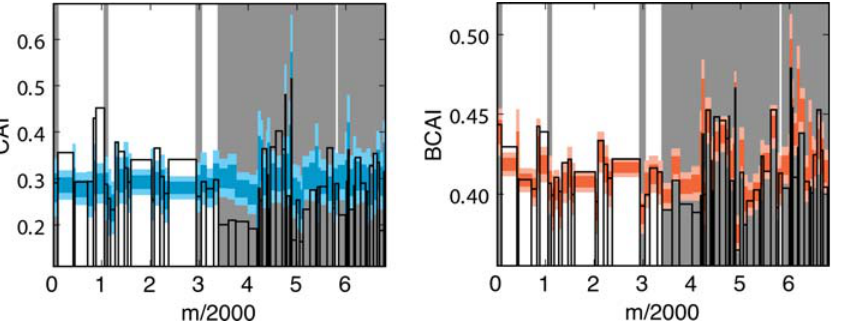
Figure 9. The relationship between codon usage and protein function in lambda phage. The figure shows the aqua (CAI, as in Figure 3) and orange (BCAI, as in Figure 5) randomization tests overlaid with information about protein function: genes classified as structural are shown with a white background and all other genes with a grey background. The histograms indicate a clear relationship between the structural classification of a gene and its significance under the aqua and orange tests: structural genes typically have elevated quantiles in the aqua test, whereas other genes typically have depressed quantiles. In other words, structural genes exhibit elevated CAI values when controlling for their amino acid sequence, compared to codon usage in the genome as a whole. Moreover, as the orange histograms indicate, this pattern is not caused by variation in GC3 content: the structural genes exhibit elevated BCAI values after controlling for both their amino acid sequence and their GC3 sequence.